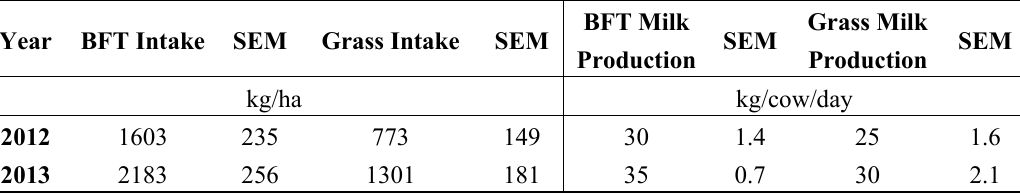
Table 2. Mean intake and milk production on pastures in 2012 and